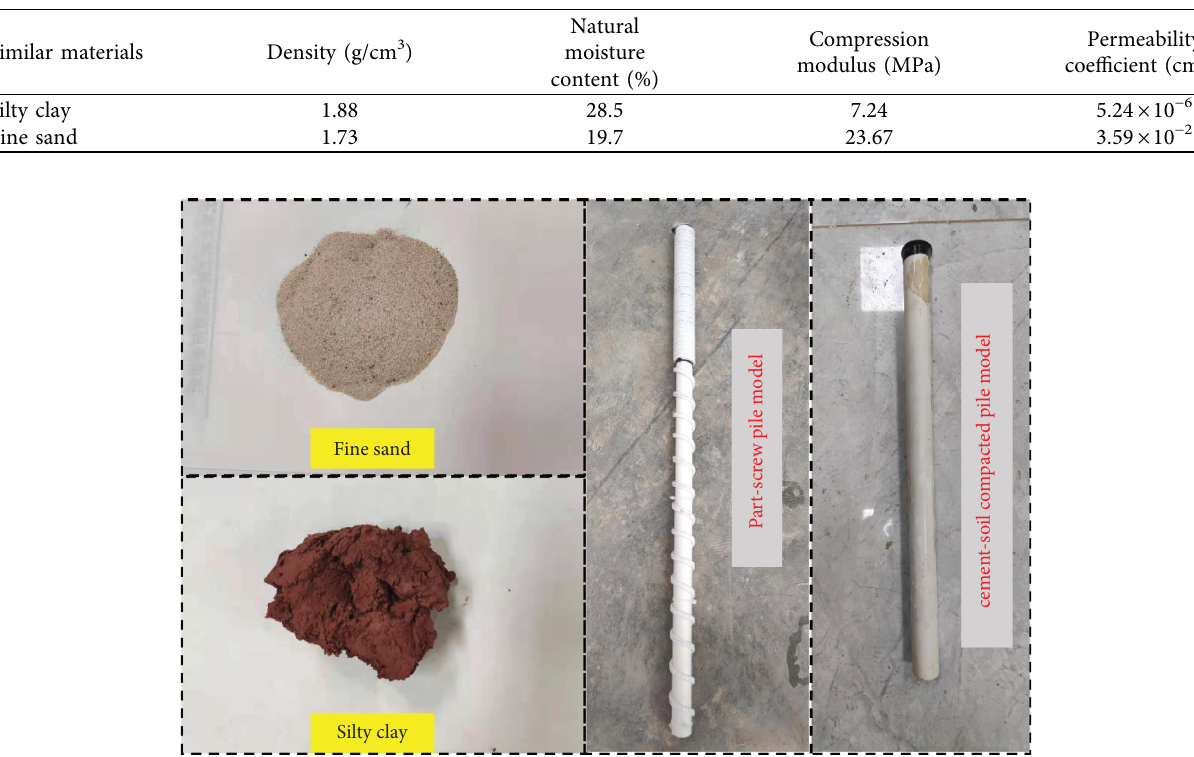
Figure 3: Model test material.